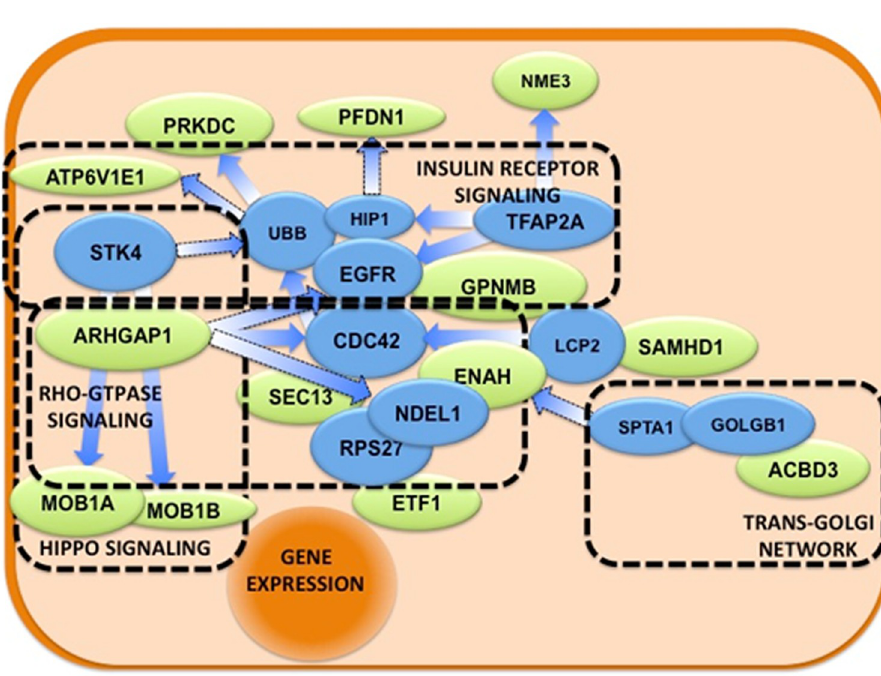
Fig 9. The biological network obtained using linker nodes for stage 3 breast cancer samples. Schematic representation of the molecular pathways in which the proteins of the set participate. Green ellipses represent proteins in the set, while blue ellipses represent ‘connector’ proteins that link all the input proteins. Overlapping proteins suggest physical interactions, while arrows indicate direct regulation. In dashed rectangles the different biological pathways that Reactome-FI detects as overrepresented in the full list (input proteins + connectors).